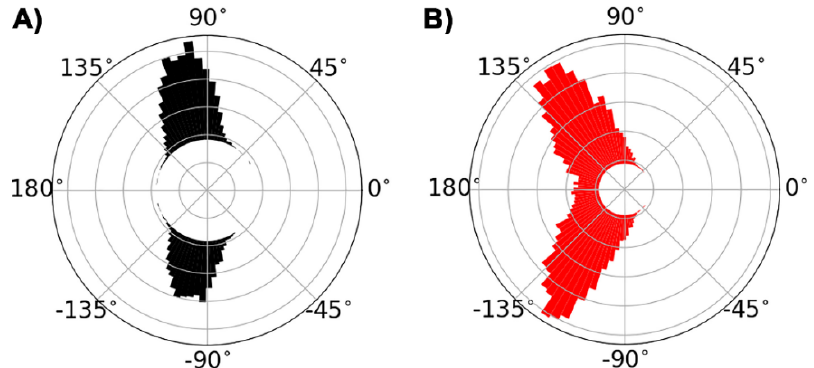
Figure 9. Polar plot showing distributions of dihedral angles rotating around the C6-C7 bond (panel ( A )) and the C7-C8 bond (panel ( B )) observed in the MD simulation of MK-4 located in the phospholipid POPC bilayer. Interestingly, the energy function observed when rotating around the C6-C7 bond is not symmetrical because the molecular shape is not symmetrical. Steric repulsions to the naphthoquinone ring substitutions are directional as described previously in detail [27].